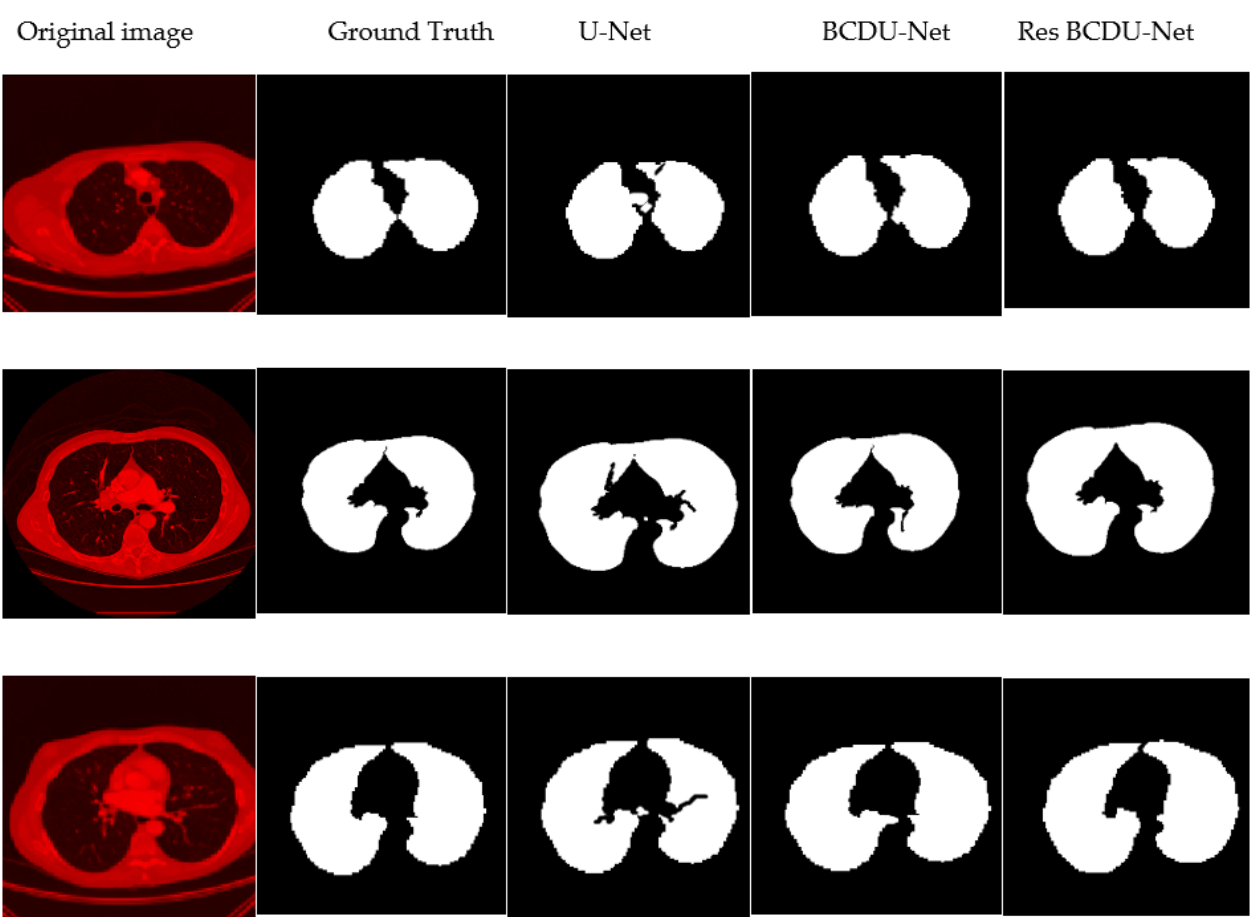
Figure 16. Sample results. From left to right: Original CT image, Ground Truth, U-Net, BCDU-Net, and Proposed method.